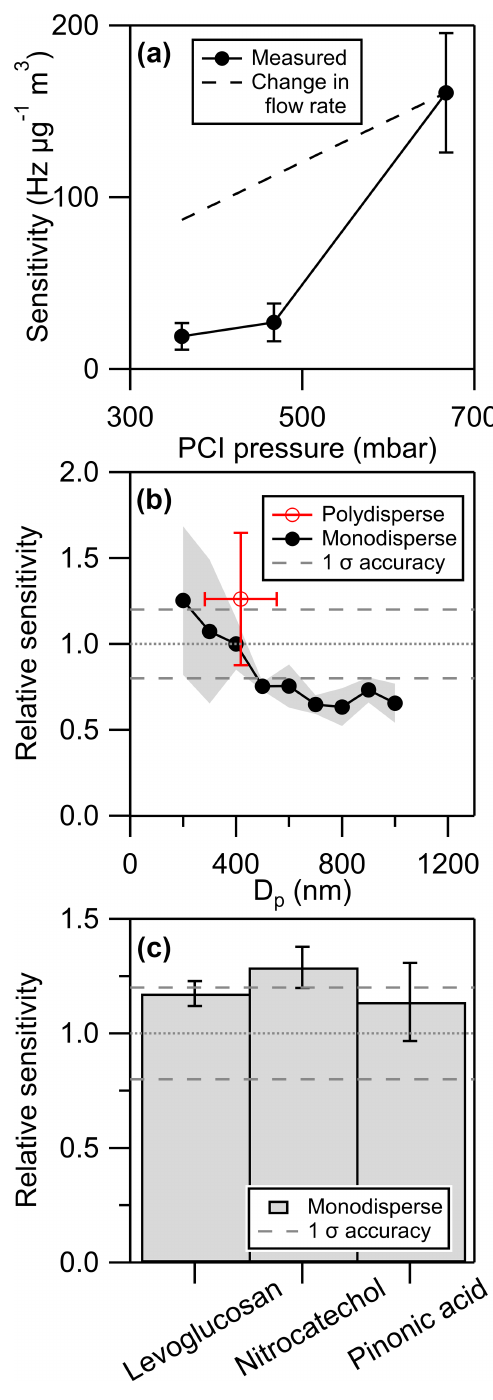
Figure 3. (a) Pressure dependence of EESI( − ) nitrocatechol sen- sitivity, (b) particle diameter dependence of EESI( + ) and EESI( − ) sensitivity for all calibrants run during FIREX-AQ scaled to sensi- tivity at 400nm, and (c) EESI-MS sensitivities of pure compounds relative to sensitivities in a 50% mole–mole mixture. Levoglucosan was mixed with ammonium sulfate and analyzed using EESI( + ). Nitrocatechol and pinonic acid were mixed with each other and an- alyzed using EESI( −